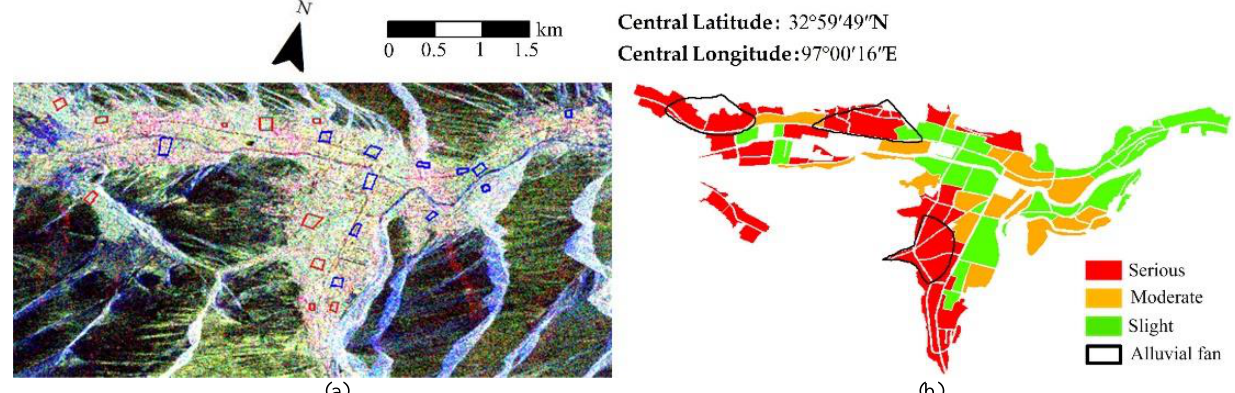
Figure 2. The C band, RARDRSAT-2 data of Yushu County: (a) Pauli RGB image; (b) Reference